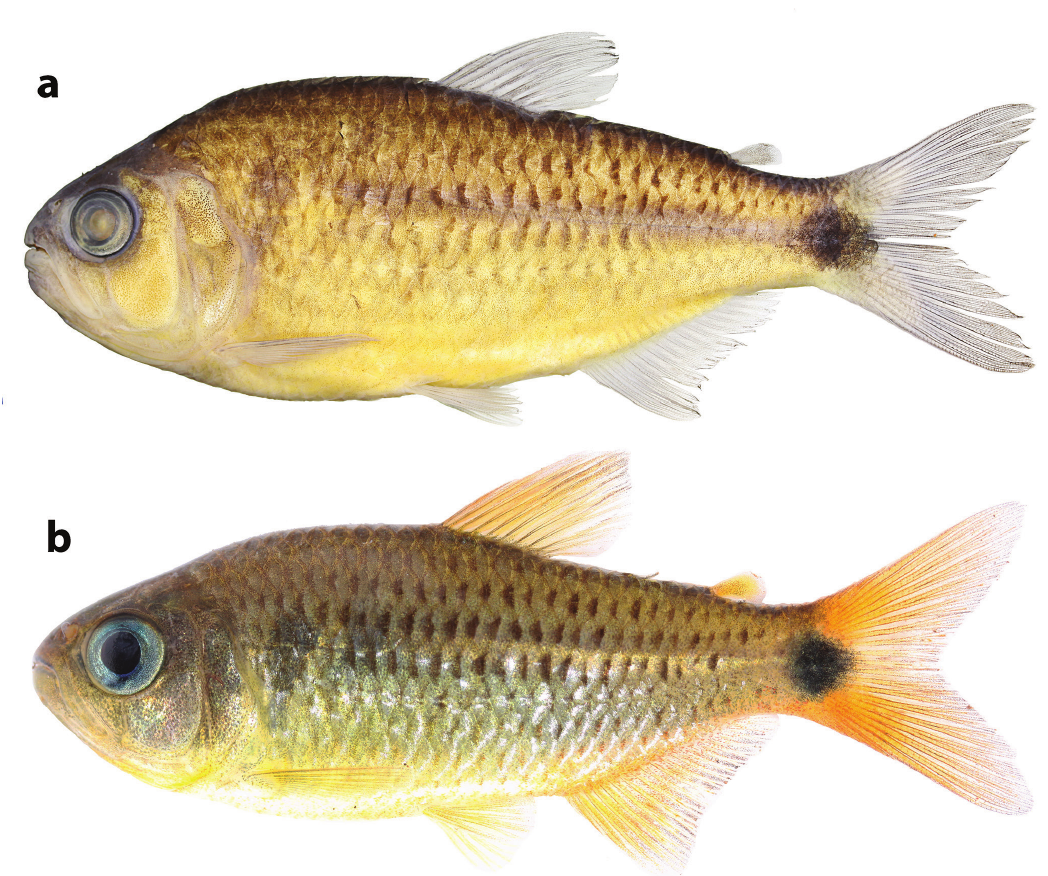
Fig. 1. Moenkhausia parecis new species, (a) holotype, MZUSP 116070, 77.9 mm SL (b) paratype, MZUSP 115509, 41.7 mm SL, immediately after capture, upper rio Machado, rio Madeira basin, Rondônia,